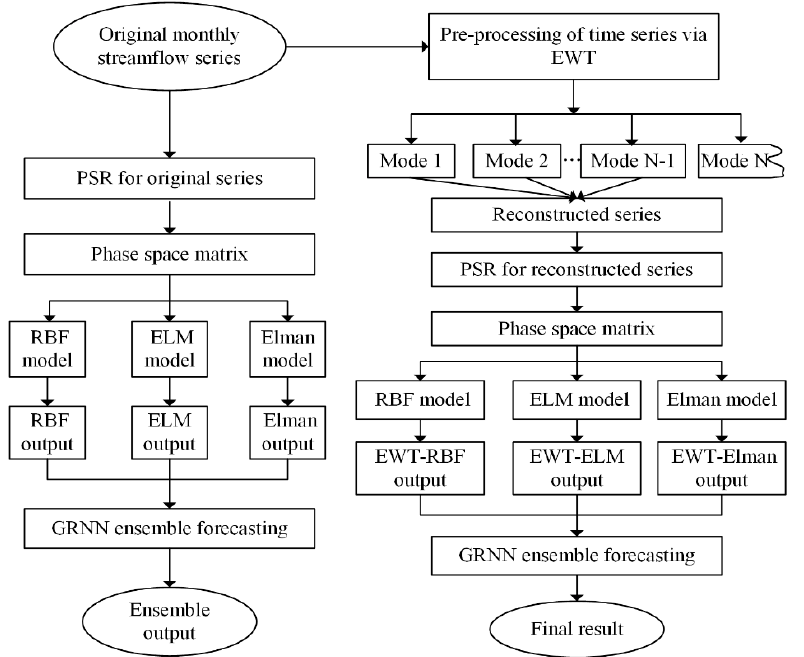
Figure 2 A schematic view of the modeling framework. Figure 2. A schematic view of the modeling